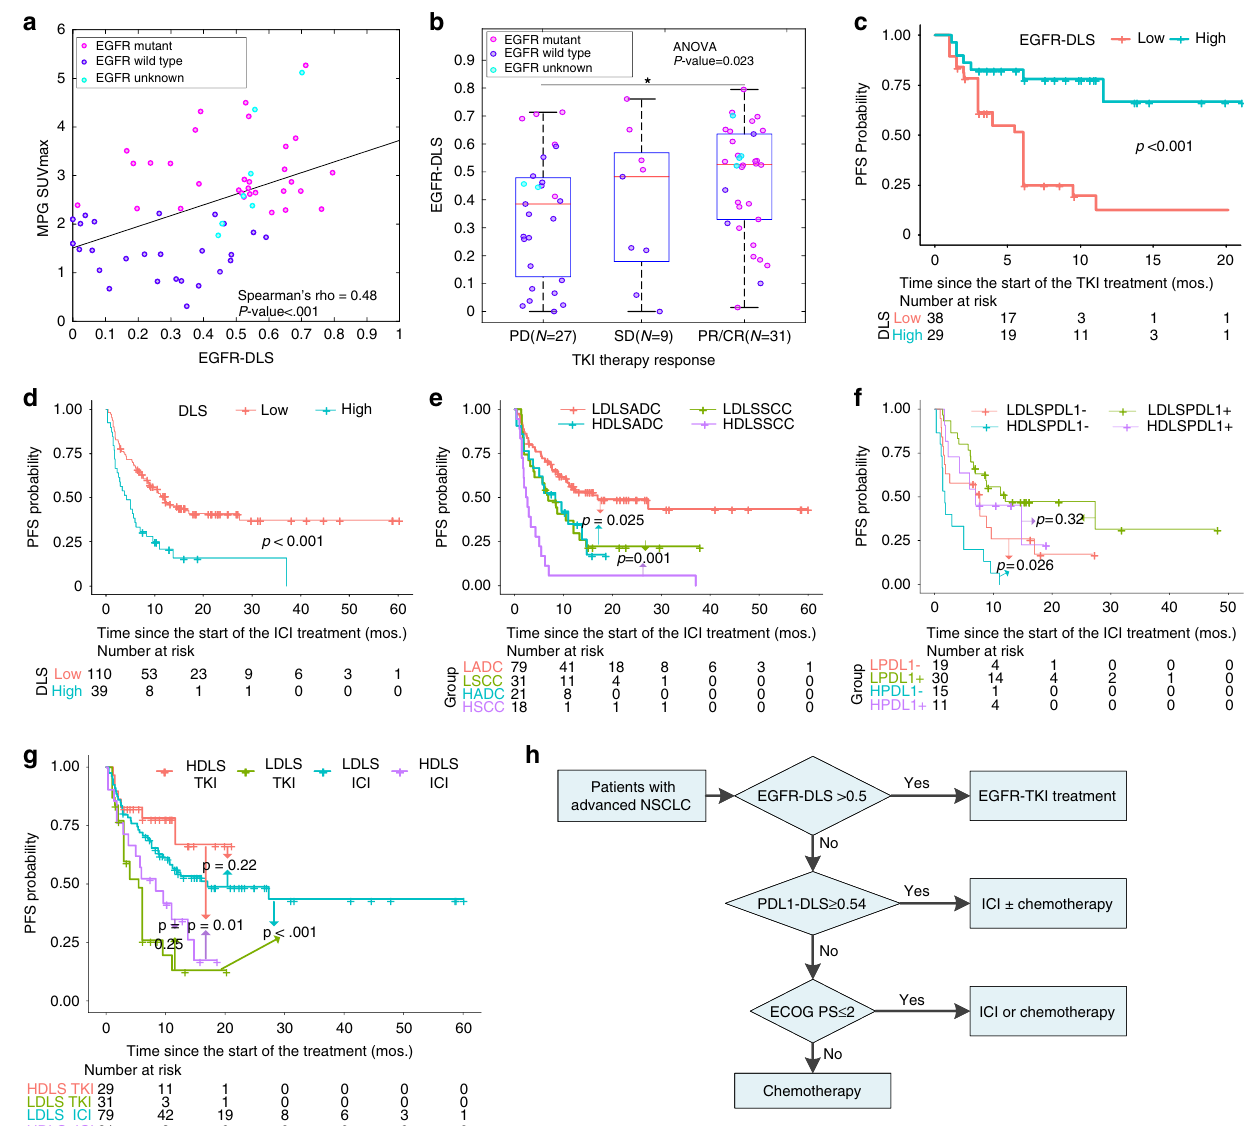
Fig. 4 Prognostic value of the EGFR-DLS in the different cohorts and in guiding treatment. a – c The prognostic value of the EGFR-DLS in the TKI-treated cohort. a The correlation between the EGFR-DLS and the SUV max of the 18F-MPG PET/CT imaging. p Value indicates two-sided Spearman rank-correlation test. b The objective response to TKI treatment relative to the EGFR-DLS. n = 27, 9, and 31 for PD, SD, and PR/CR groups, respectively. In the box plot, the central line represents the median, the bounds of box the fi rst and third quartiles, and the whiskers are the interquartile range. p Value shows two-sided ANOVA. * denotes a p value <0.05. c The progression survival of patients relative the EGFR-DLS (cutoff: 0.5). d – f Prognostic value of the EGFR-DLS in the ICI-treated cohorts. d The progression survival of patients relative the EGFR-DLS. e The progression survival of patients relative the EGFR-DLS and histology type (ADC adenocarcinoma, SCC squamous cell carcinoma). f Progression-free survival of patients relative the EGFR-DLS and PD-L1 status (EGFR-DLS cutoff: 0.5). HDLS high EGFR-DLS, LDLS low EGFR-DLS, PD-L1 − PD-L1 negative (i.e., the tumor proportion score (TPS) < 1%), PD-L1 + PD-L1 positive (i.e., the tumor proportion score (TPS) ≥ 1%). The LPDL1 − patients with low EGFR-DLS and negative PD-L1 status, LPDL1 + patients with low EGFR- DLS and positive PD-L1 status, HPDL1 − patients with high EGFR-DLS and negative PD-L1 status, HPDL1 + patients with high-EGFR-DLS and positive PD-L1 status. g The progression survival of patients relative the EGFR-DLS and different treatment using the combined TKI-treated and ICI-treated cohorts with adenocarcinoma (EGFR-DLS cutoff: 0.5). HDLS high EGFR-DLS, LDLS low EGFR-DLS. Comparisons of the above progression survival curves were performed with a two-sided log-rank test. h Proposed alternative guideline to use EGFR-DLS, PDL1_DLS, and ECOG PS score for decision support for NSCLC patients. ECOG PS Eastern Cooperative Oncology Group performance